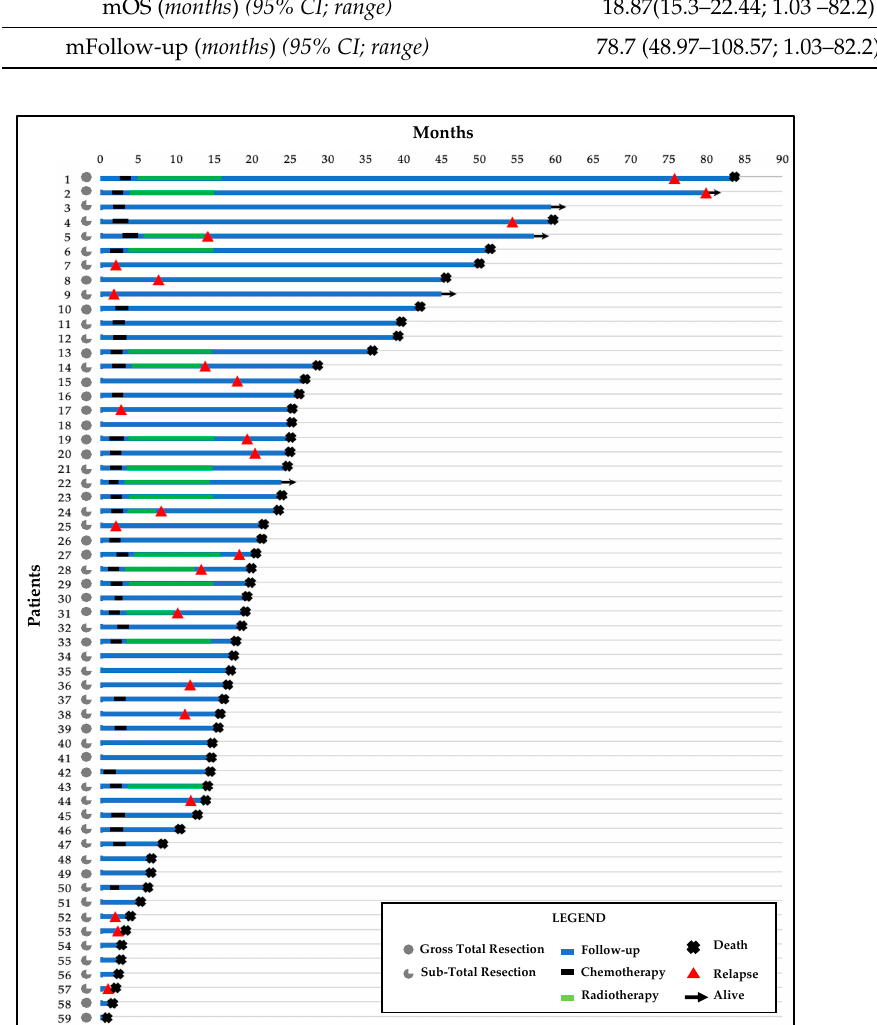
Figure 1. Swimmer’s plot with follow-up time, treatments, and clinical outcomes for the 59 patients.